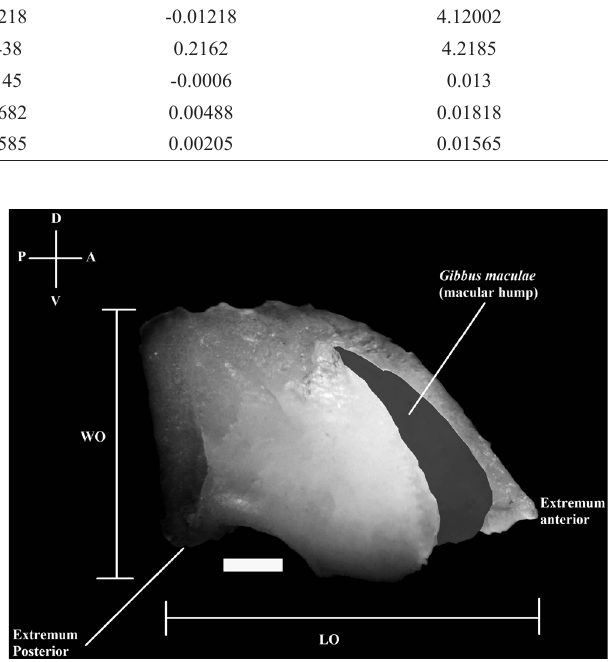
Fig. 2. Lapillus otolith images of Prochilodus lineatus from a scanning electron microscope with 40X magnification . LO – otolith length; WO – otolith width; the white bar scale is equal to 1 mm. V – Ventral; D – Dorsal, P – Posterior; A – Anterior; the highlighted region (grey region – highlighted digitally) is the macular